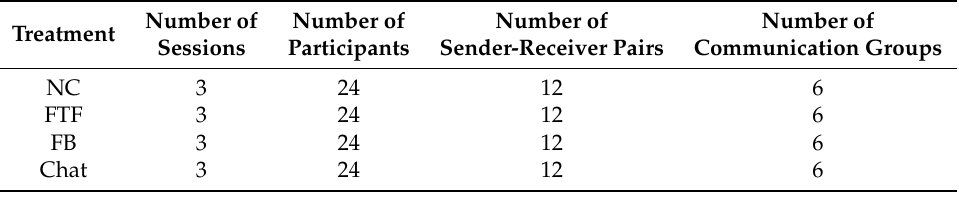
Table 1. Treatment